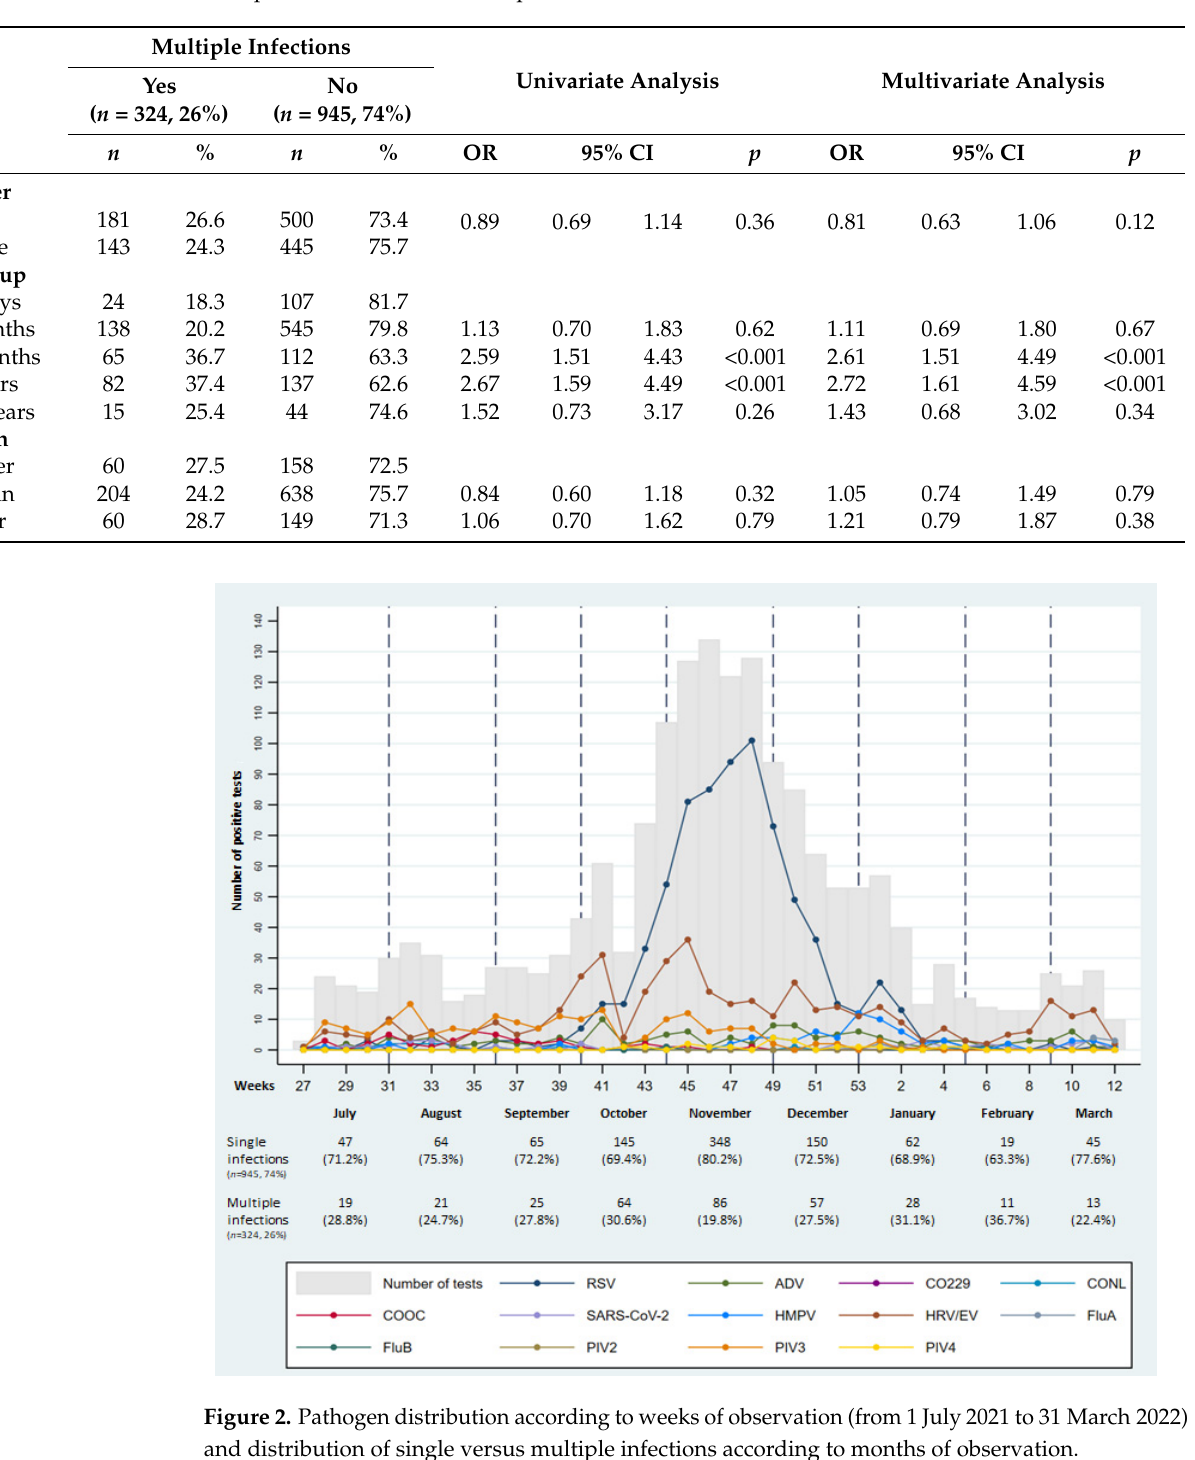
Figure 3. Hospitalization due to RSV infection during the pre-pandemic seasons (2018–2019 and 2019–2020) and during the 2020–2021 year of SARS-CoV-2 pandemic. 4. Discussion